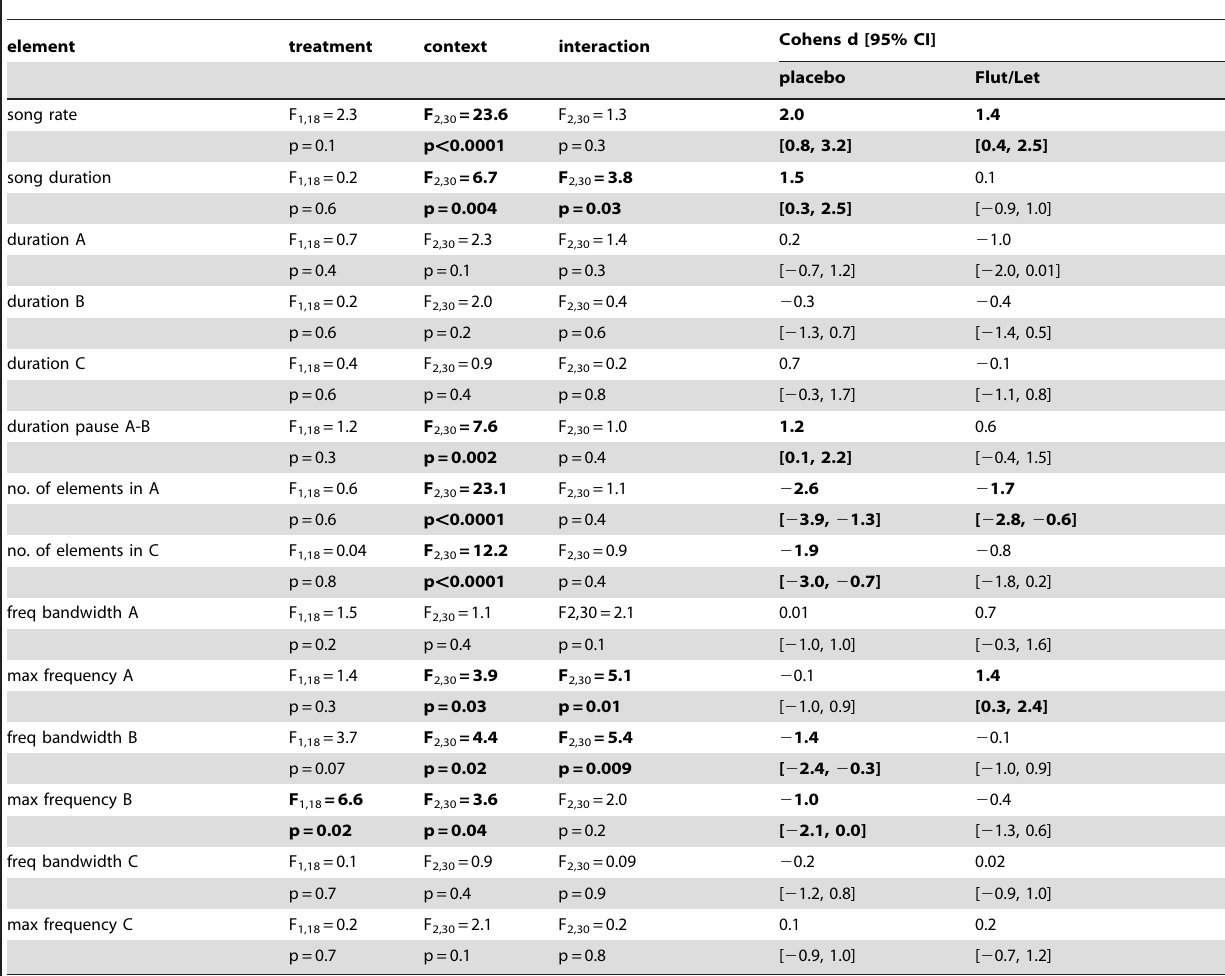
Table 1. Linear mixed model results for the effects of context and Flut/Let-treatment on song output and structure in spring.